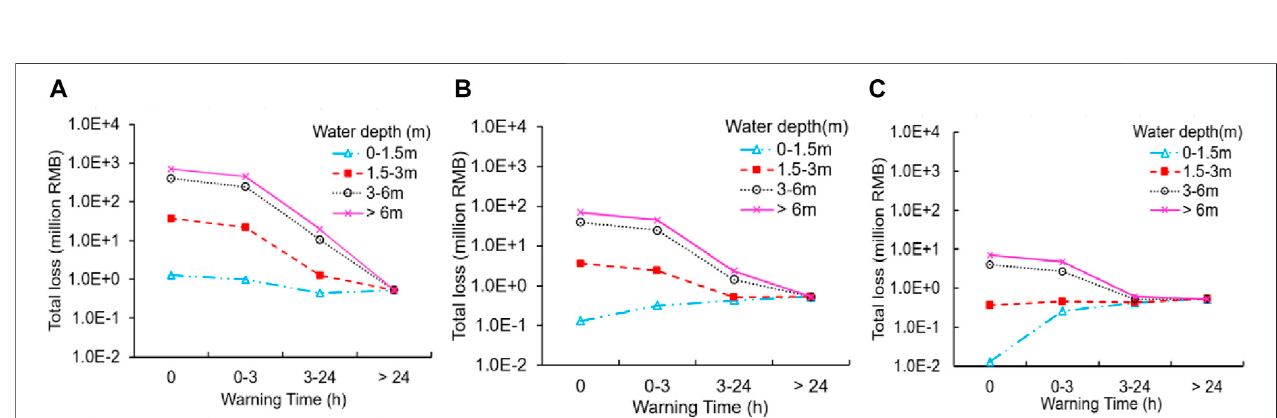
Frontiers in Earth Science |